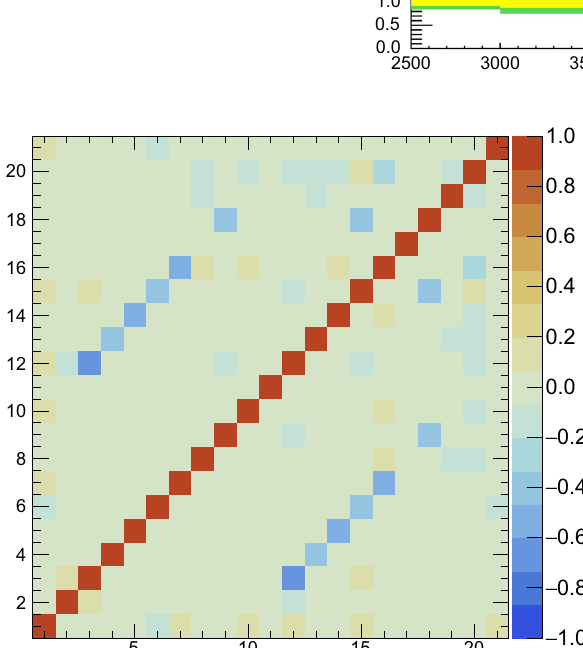
Fig. 8 Energy spectra of single-hit α events in C2. The simulation results are fitted to the measured data (top panel). The lower panel shows the bin by bin ratios of data to fitted result; the colored bands centered at 1 in the lower panel represent 1 and 2 σ of the total uncertainty obtained by the quadratic summing systematic uncertainty from the energy scale and uncertainty of fit parameters from the modeling. The uncertainty of the data/fit ratio is the statistical error